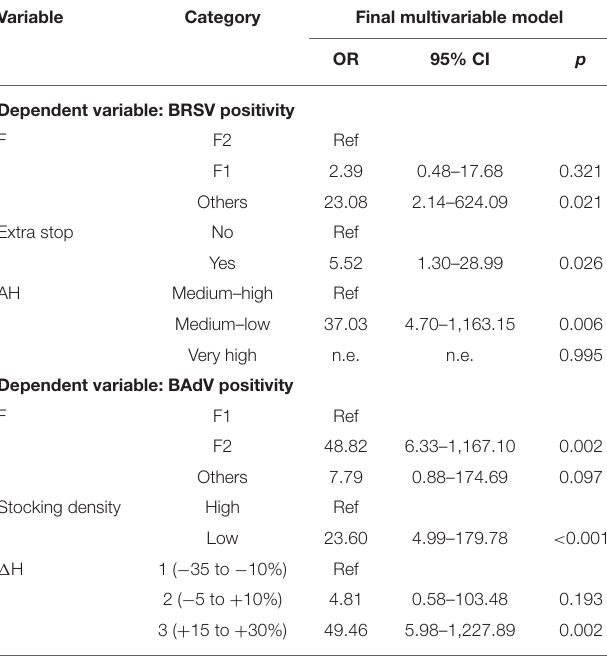
TABLE 6 | Final multivariable regression models for the dummy dependent variables of positivity/negativity to bacterial infections.